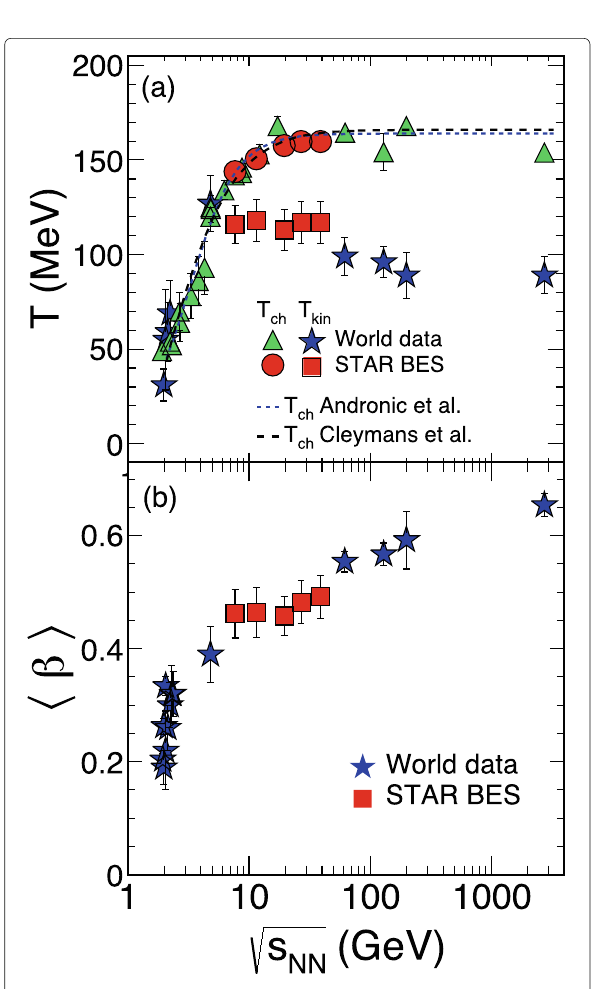
Fig. 15 Collision energy dependence of a extracted chemical and kinetic freeze-out temperatures ( T ch and T kin ) and b average transverse flow velocity ( (cid:5) β (cid:6) ) [4]. This figure is adapted from Ref.